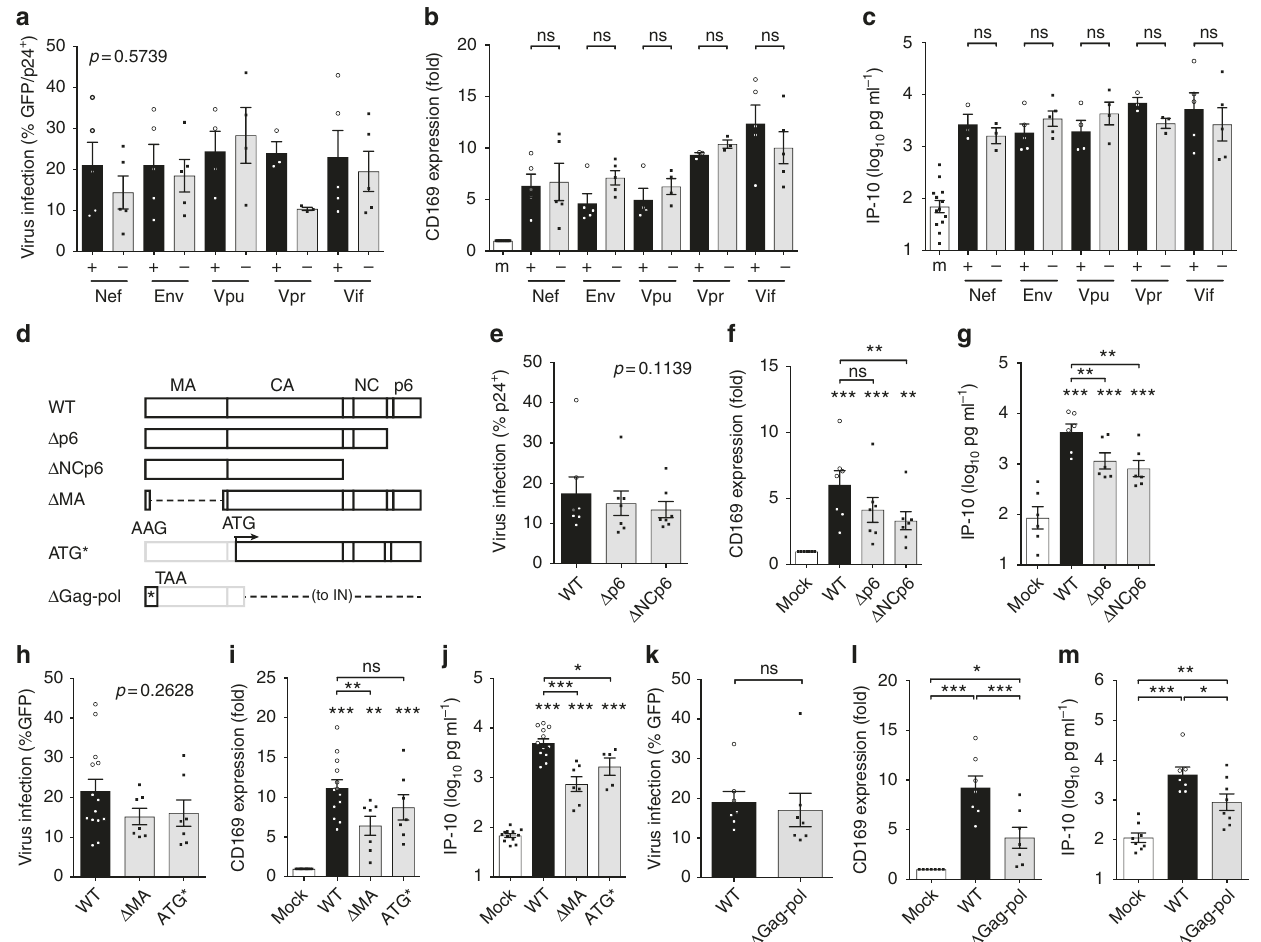
Fig. 2 Structural and accessory proteins of HIV-1 do not encode immune activation determinants. a – c Gag or GFP (viral) expression ( a ), CD169 expression ( b ), and IP-10 production ( c ) in MDMs 6 days post infection with replication competent HIV-1 (Vpu + / − and Env + ) or VSV-G-pseudotyped single- round viruses (Nef + / - , Env − , Vpr + / − , and Vif + / − ) at MOI of 1. d Schematic of HIV-1 Gag mutants. e – m Gag or GFP (viral) expression ( e , h , k ), CD169 expression ( f , i , l ), and IP-10 production ( g , j , m ) in MDMs 6 days post infection with HIV-1 (MOI of 2). m: mock. The means± SEM are shown and each symbol represents an independent experiment. Two-tailed p -values: one-way ANOVA followed by the Tukey-Kramer post-test ( b , c , f , g , i , j , l and m ) and/or the Dunnett ’ s post-test ( f , g , i , and j ), or paired t -test ( k ). * p < 0.05, ** p < 0.01, *** p < 0.001, ns: not signi fi